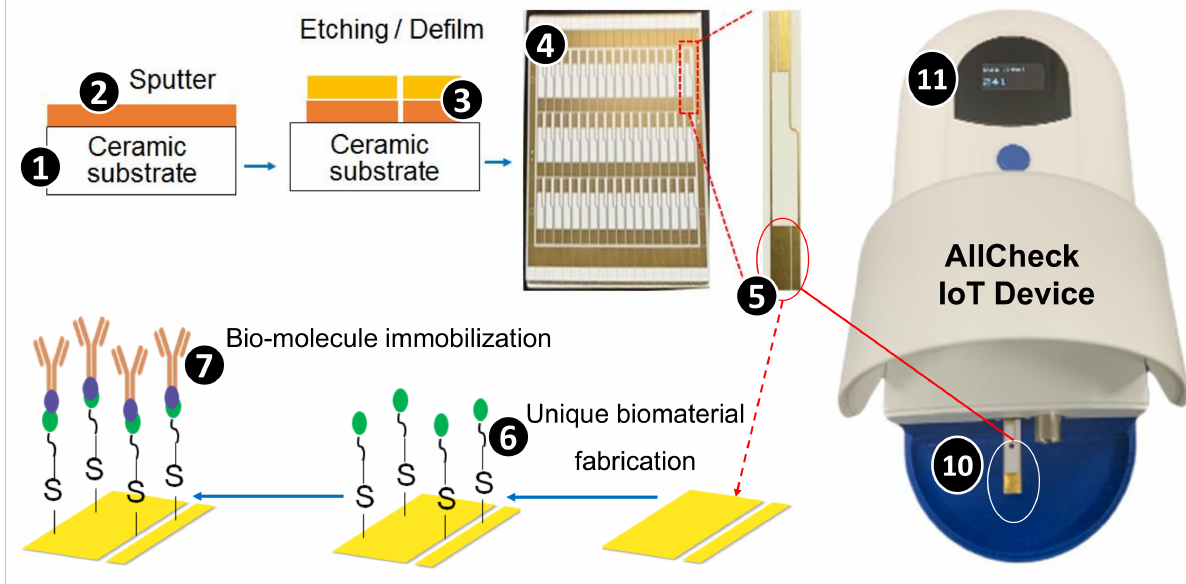
Figure 2. Development of a Point-of-Care (POC)